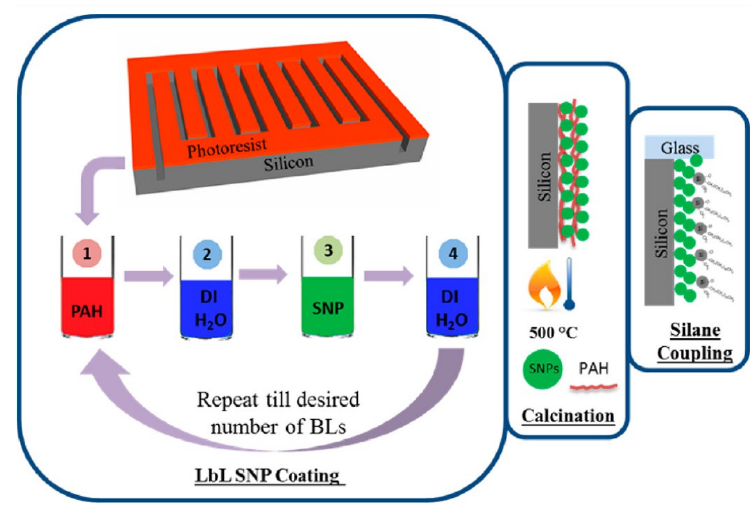
Figure 4: Schematic process flow of SNPs coating using layer-by-layer self-assembly technique.